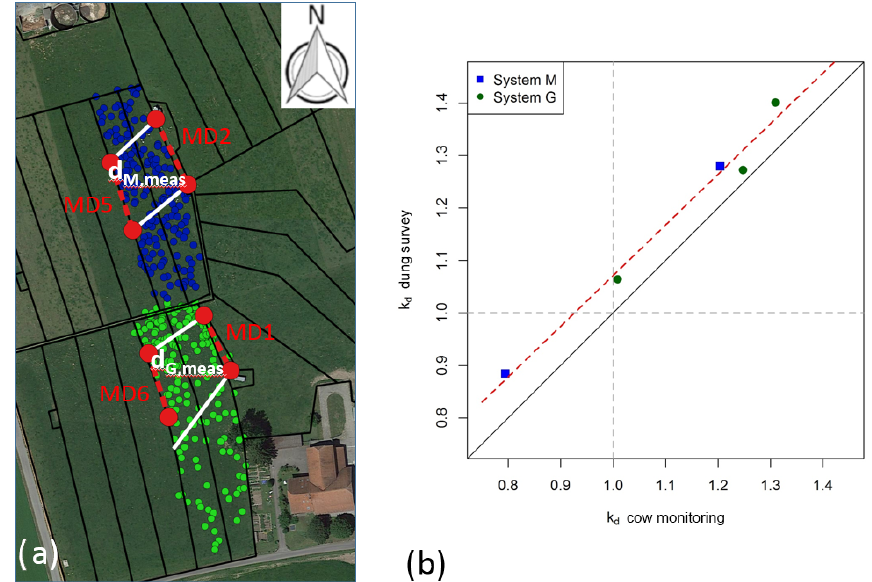
Figure 3. (a) GPS-tagged dung positions recorded after grazing rotation 7 overlaid on a Google Earth image of the experimental area (map data: Google, DigitalGlobe). The positions of the MD ammonia sensors and paths are indicated by the red dots and dotted lines. The white lines enclose the main emission measurement area between the sensors. Their dung patch density d X. meas was related to the average density over the investigated paddocks according to Eq. (2); (b) comparison of k d values according to Eq. (2) for dung patch and cow position distributions on system M (blue) and system G